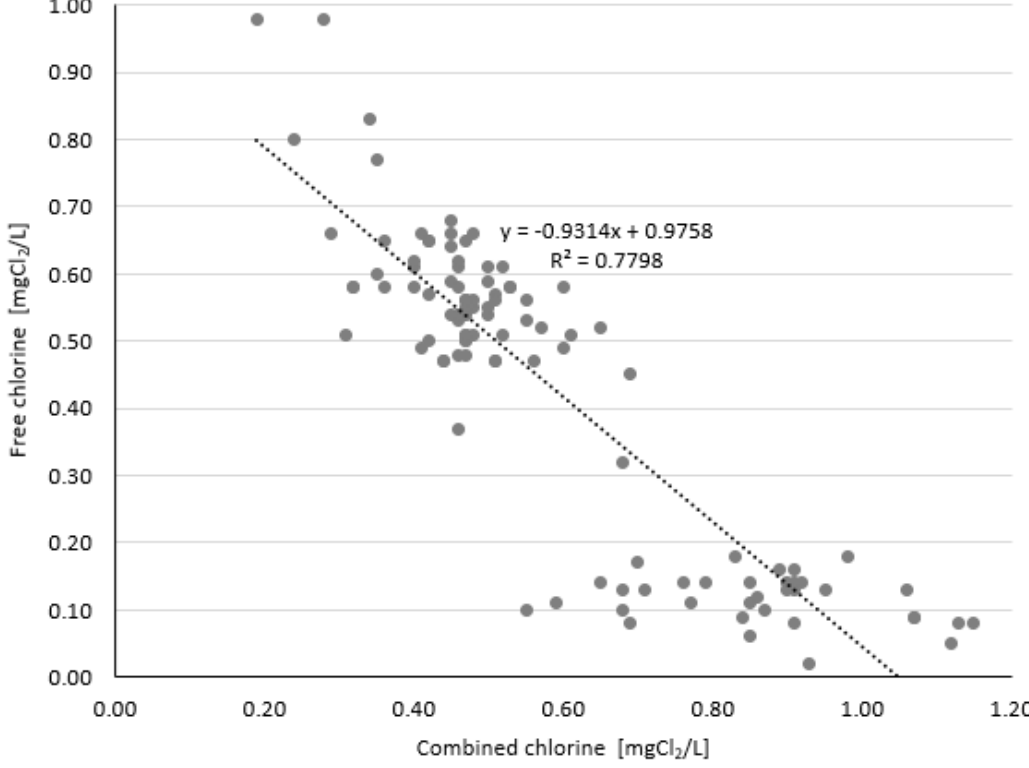
Figure 5. The correlation between the content of free and combined chlorine in tested pools.